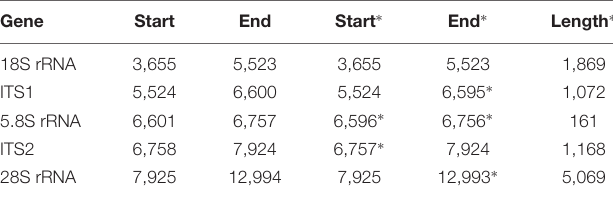
TABLE 1 | Annotation of human rRNA genes with